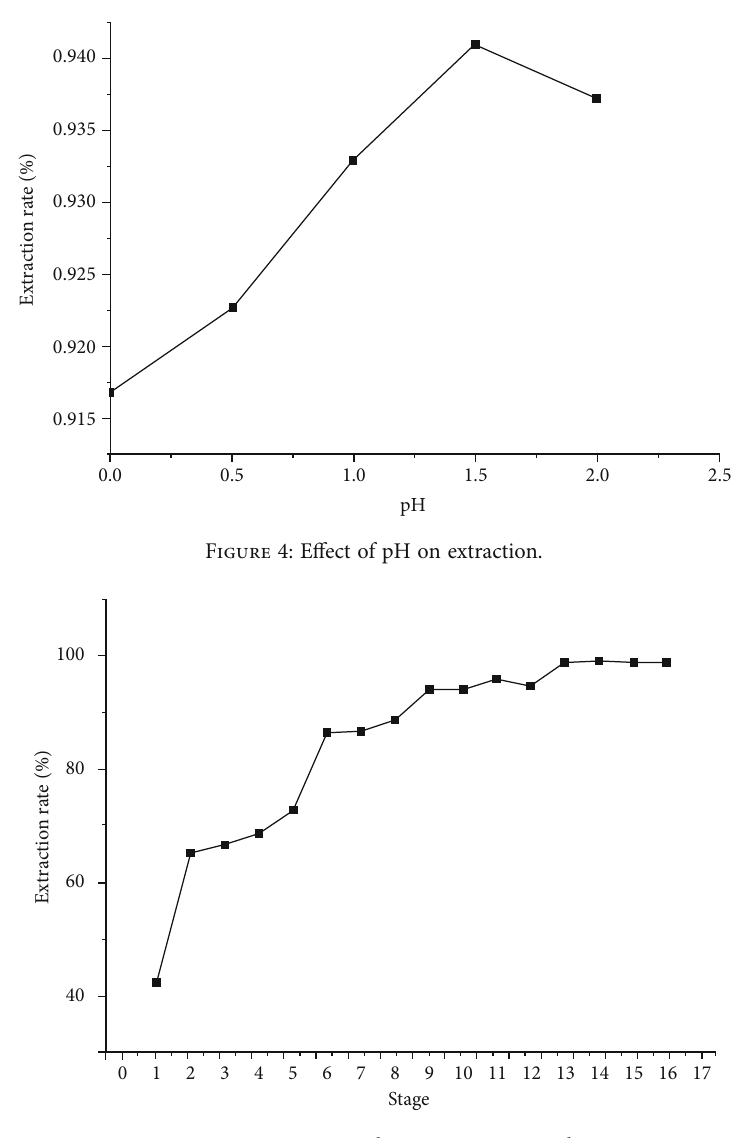
Figure 5: Extraction with 16-stage mixer-settler. Table 3: Feed liquid extraction test results.